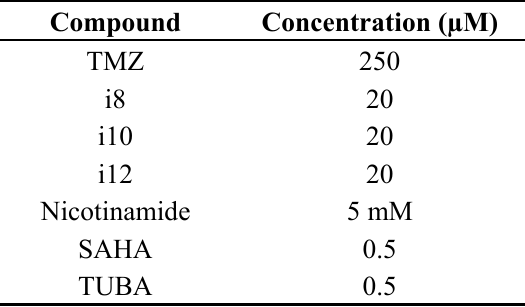
Table 2. Compound concentrations used for crystal violet assays (cytotoxicity) and for treatment for metabolomics analysis. Cell survival was measured following 72 h